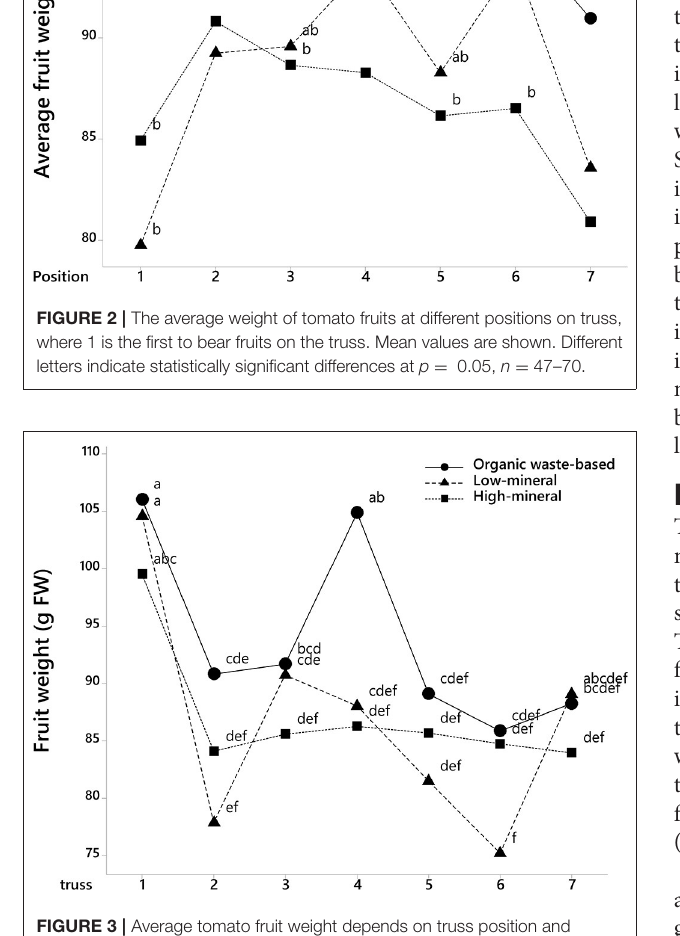
FIGURE 3 | Average tomato fruit weight depends on truss position and treatment, where 1 is the first to develop truss. Mean values are shown. Different letters indicate statistically significant differences at p = 0.05, n =